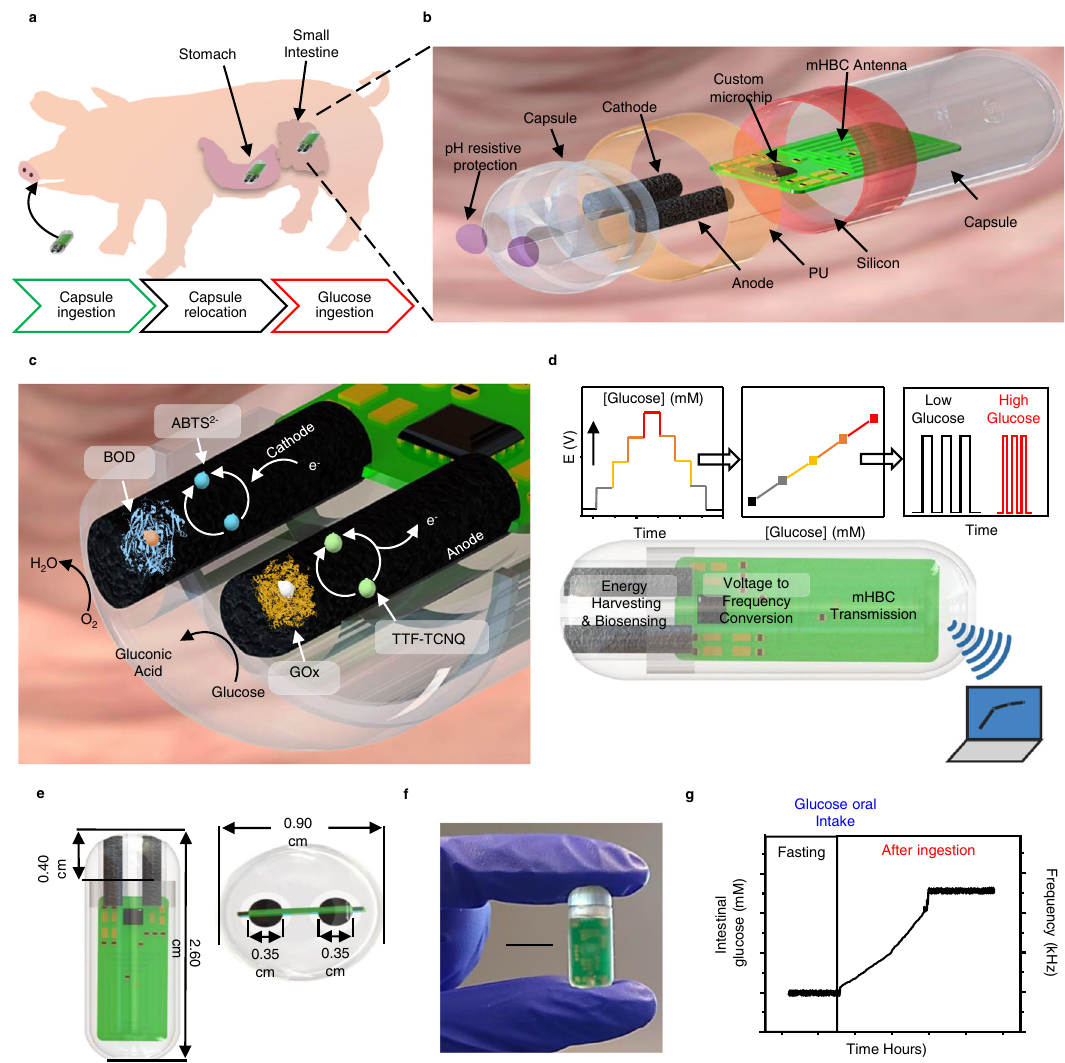
Fig. 1 | Design and sensing mechanism of the ingestible self-powered BFC capsule sensor. a Schematics of the capsule sensor operating in a porcine model. b Schematiclayoutofthecapsulesensor. c Illustrationofthechemicalcomposition and reaction mechanisms inside the BFC sensor. d Signal conversion mechanism converting glucose concentrations to voltage, then to mHBC modulation signal